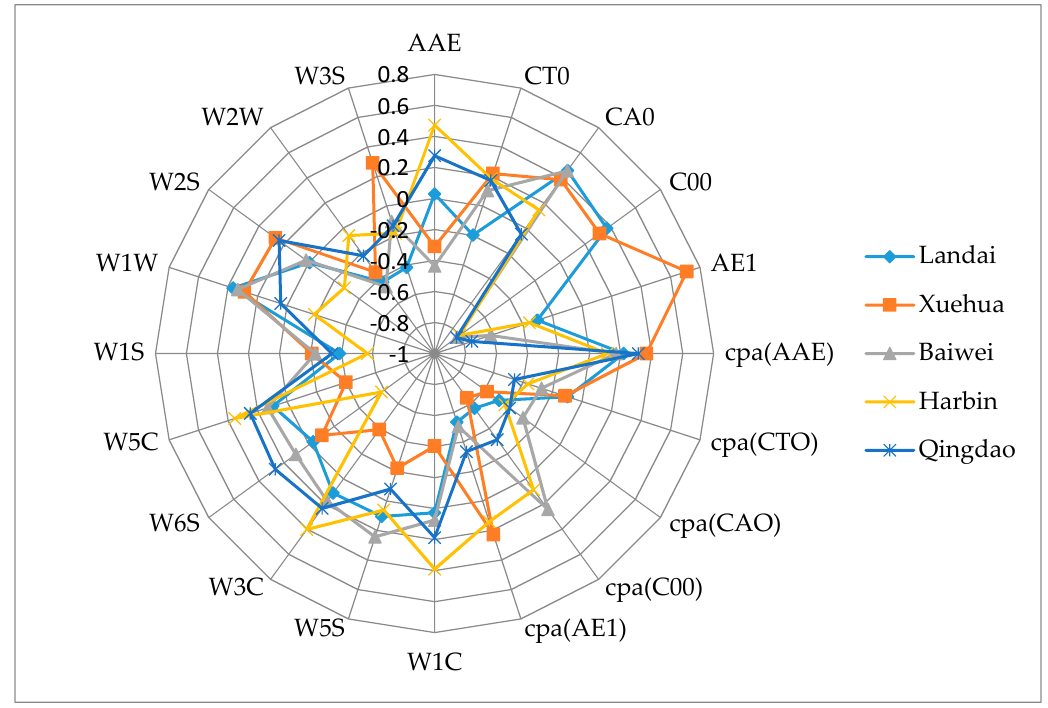
Figure 4. A radar plot of the different sensors to five beer samples.